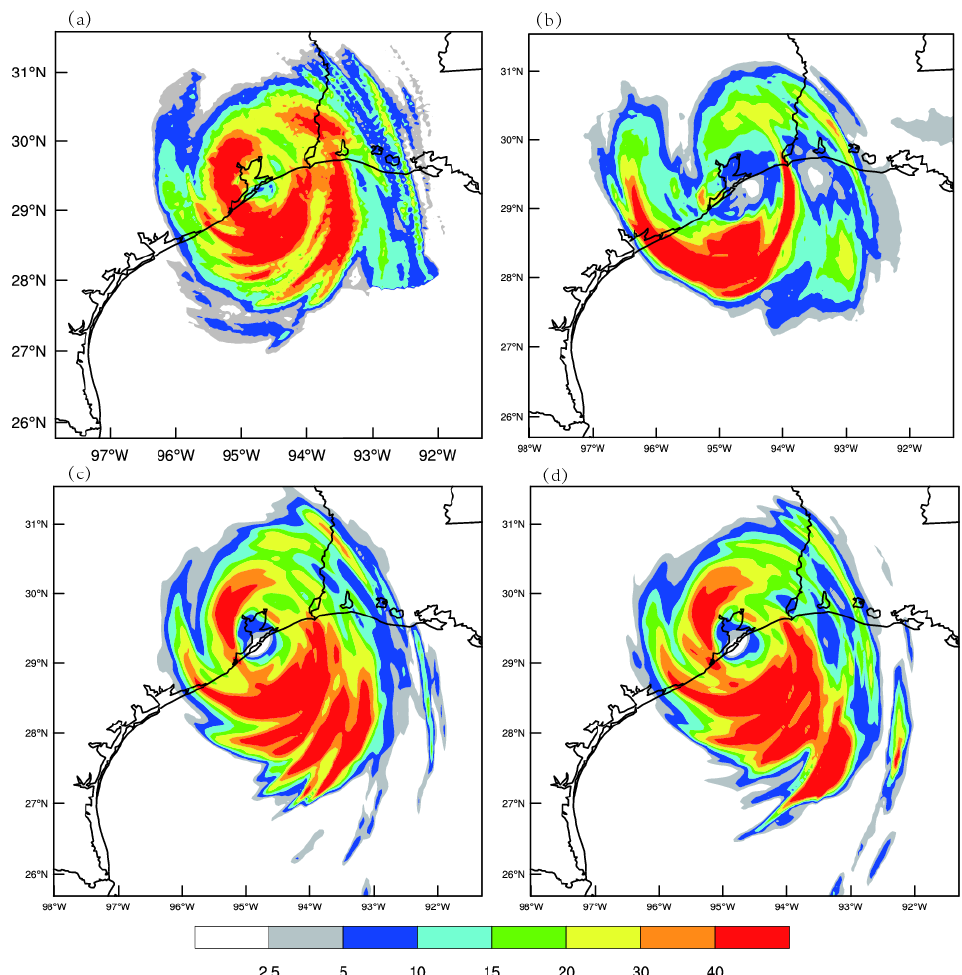
Figure 10. The 3 h accumulated precipitation in ( a ) observation, ( b ) DA_CONV experiment, ( c ) DA_Radar experiment, ( d ) DA_Radar_CVH experiment from 0600 UTC, 13 September to 0900 UTC, 13 September.